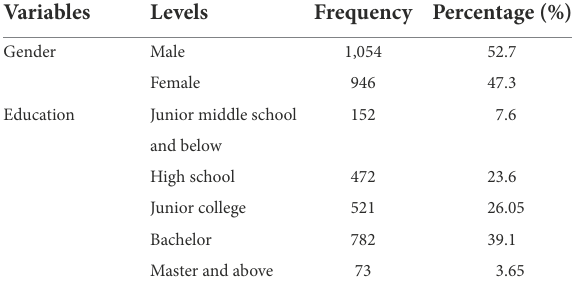
TABLE 1 Participant composition ( N =